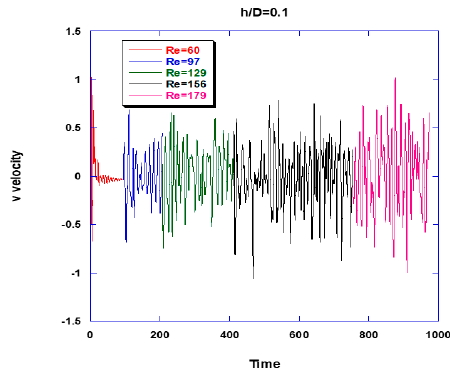
Figure 4. Time series of the instantaneous normalized transverse ( v ) velocity component for progressively increased Re numbers; h / D = 0.1. The v -velocity component is normalized with U and the time with D ’/ U .